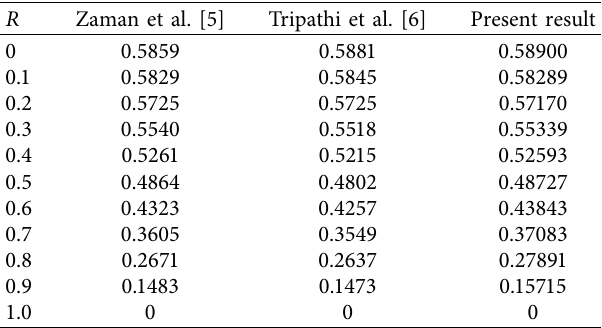
Figure 3: (a) Local error on w and θ . (b) Sum of time and space error on w and θ . Table 2: Validation of biomagnetic blood axial velocity with Zaman et al. [5] and Tripathi et al. [6].